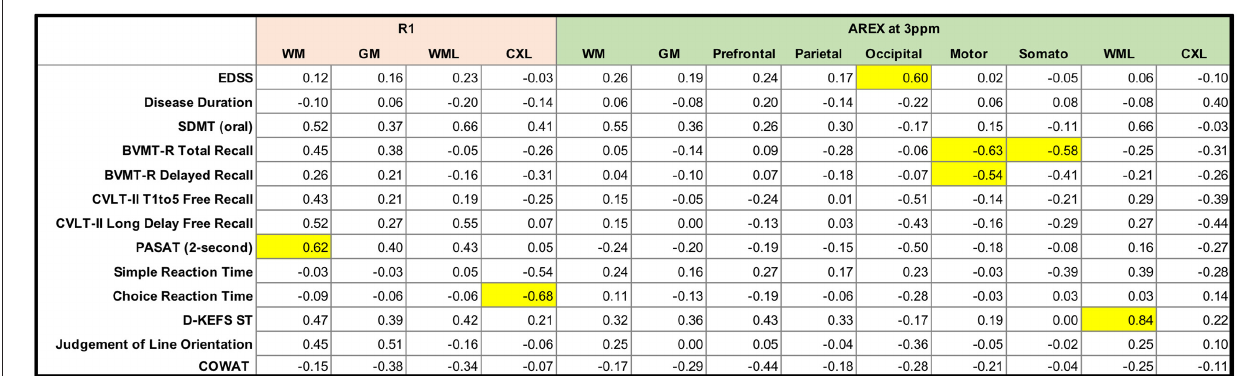
FIGURE 6 | Matrix of Spearman rho values for partial correlations between clinical and cognitive variables and mean R 1 and AREX values in patients with MS. Age, education, and sex were included as covariates. Correlations are highlighted in yellow if p < 0.05. SDMT = Symbol Digit Modalities Test; BVMT-R = Brief Visuospatial Memory Test-Revised; CVLT-II = California Verbal Learning Test, 2nd edition; PASAT = Paced Auditory Serial Addition Test; D-KEFS ST = Delis-Kaplan Executive Function System Sorting Test; COWAT = Controlled Oral Word Association Test.